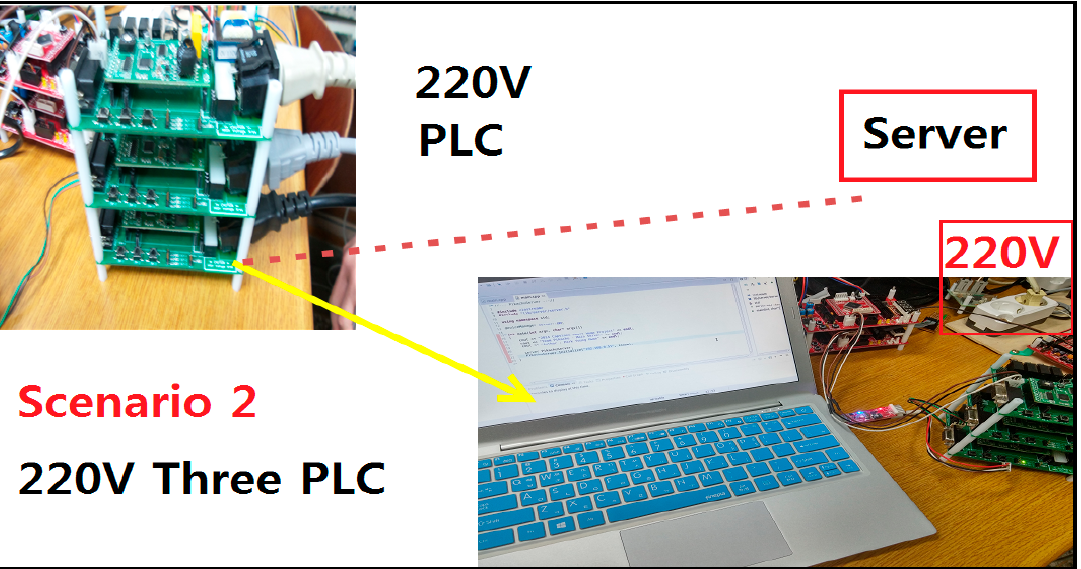
Figure 9. Scenario 2 (220 V Three PLC).